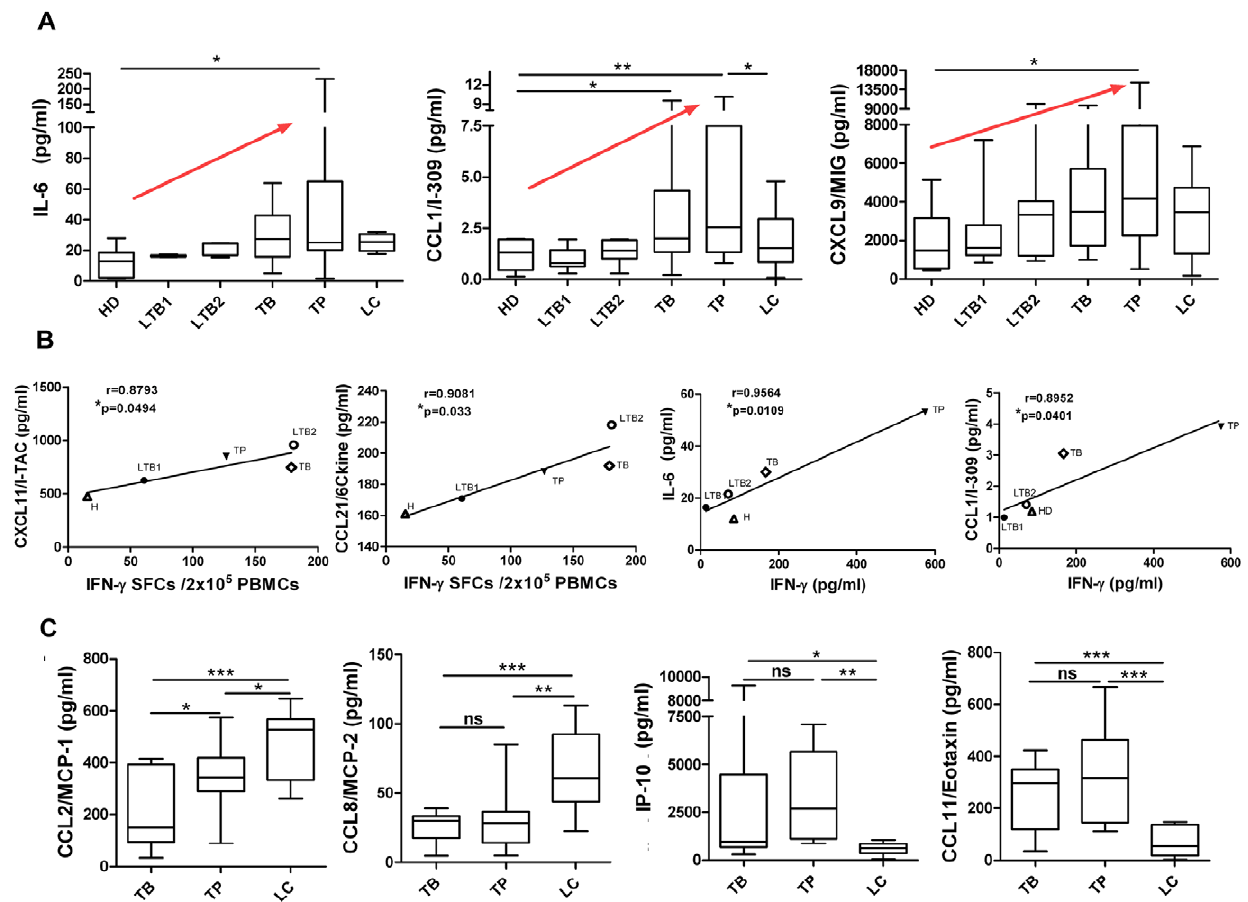
Figure 2. Differences in cytokine/chemokine expression among distinct clinical groups. A: IL-6, CCL1 and CXCL9 levels in plasma from healthy donors, LTB1 and LTB2 individuals, active TB patients, tuberculous pleurisy patients and lung cancer patients. A red arrow indicates an upward trend. B: Correlation analysis between CXCL11 and CCL21 concentrations in the HD, LTB1, LTB2, TB and TP groups and the IFN- c ELISPOT SFC values; and the correlation analysis between IL-6 and CCL1 concentrations and IFN- c plasma concentration. The correlation coefficients were assessed using Pearson’s two-tailed correlation test. C: CCL2, CCL8, IP-10 and CCL11 levels in active pulmonary TB, tuberculous pleurisy and lung cancer patients. Horizontal bars represent median values, boxes represent the interquartile range (25–75%) and whiskers represent the highest and the lowest values. Horizontal lines indicate a statistically significant difference between groups. *p , 0.05; **p , 0.005.